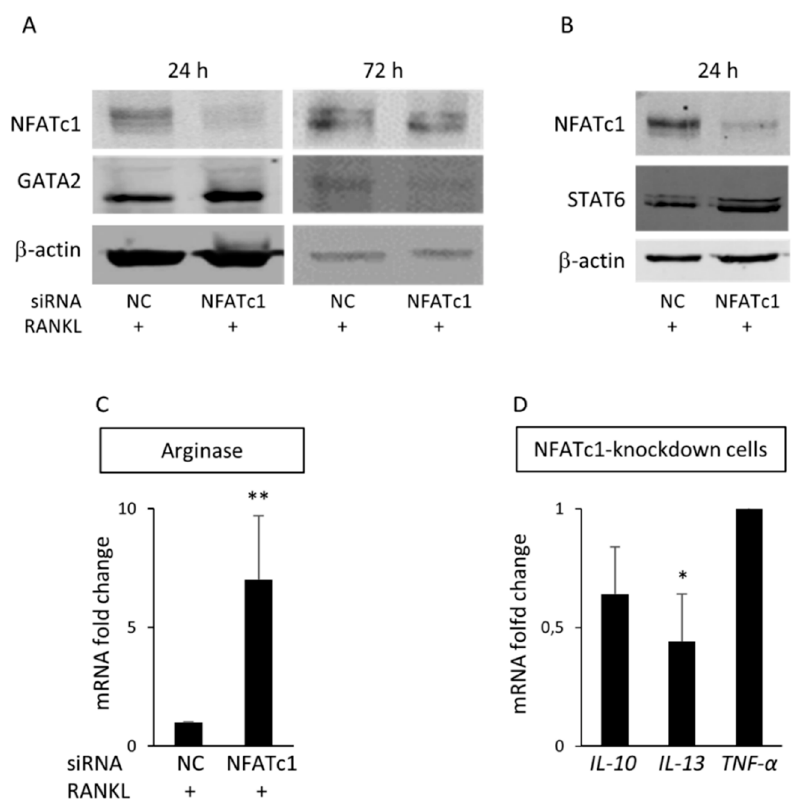
Figure 7. GATA2 is a new target of NFATc1. Cells were transfected with siRNA-NC and siRNA-NFATc1 for 24 and 72 h before protein expression levels were analyzed. ( A ) Western blot of NFATc1 and GATA2 after 24 and 72 h. ( B ) Western blot of NFATc1 and STAT6 after 24 h. β -actin was used as loading control. The data shown represent two independent experiments with comparable outcomes. ( C ) QPCR of Arginase 1 . ( D ) QPCR of IL-10, IL-13 and TNF- α . mRNA expression is presented as relative values to those expressed in siRNA-NC transfected cells arbitrarily set at 1.0. The results shown are the means ± SD of three experiments (each of which was performed in triplicate). * p < 0.05 ** p < 0.01.